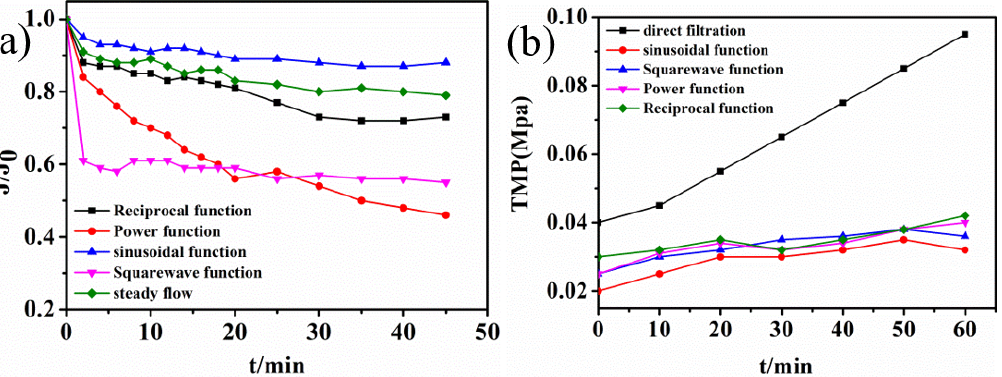
Figure 7. Different function feeding modes. ( a ) Membrane-specific flux time diagram. ( b ) Transmembrane pressure difference time diagram.